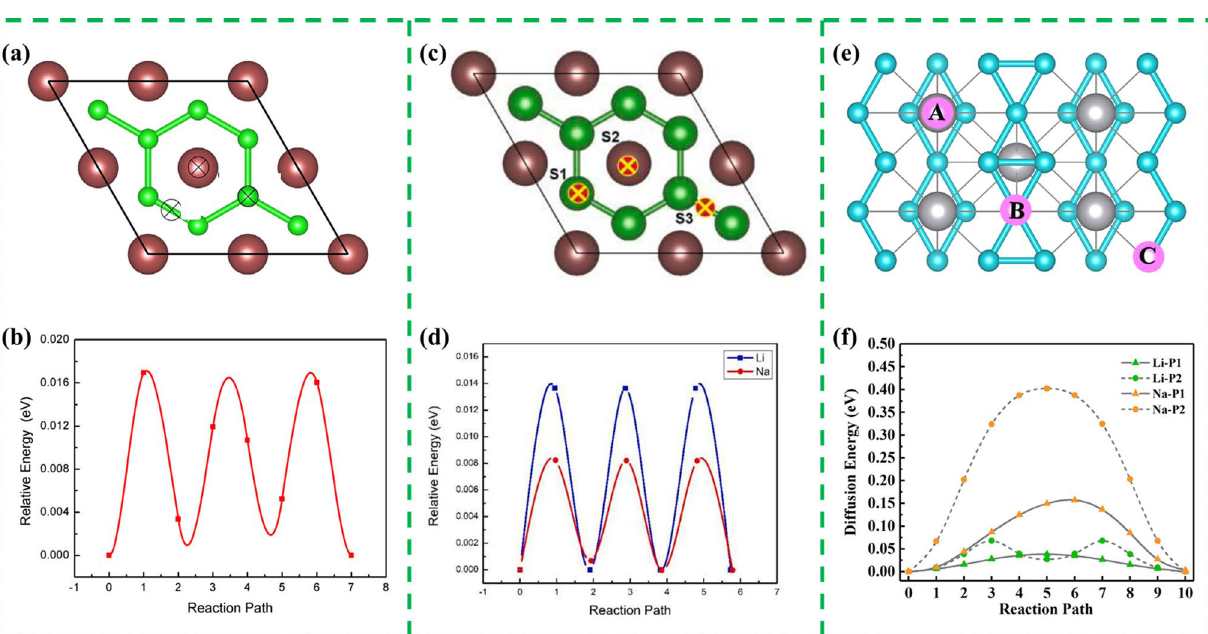
Fig. 21 a Top view of the stable structure of the monolayer Zr 2 B 2 . The brown and green balls represent the Zr and B atoms, respectively. b The energy during the diffusion process on the monolayer Zr 2 B 2 . Reproduced with permission from Ref. [230]. c Top view of 2D Y 2 B 2 crystal structures. The Y and B atoms are denoted by brown and green spheres. d The diffusion energy barrier curves of M on Y 2 B 2 . Reproduced with permission from Ref. [234]. e The adsorption site of Li/Na on TiB 3 monolayer. f Diffusion barrier of Li and Na on TiB 3 monolayer along P1 and P2, respectively. Reproduced with permission from Ref.